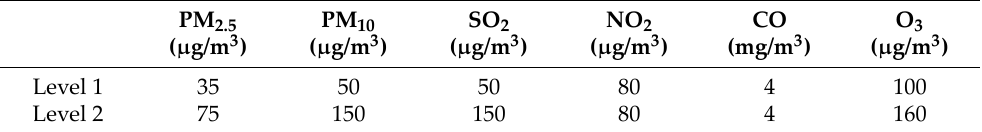
Table 3. The reference limits of pollutant concentration given by China’s environmental protec‑ tion authorities.